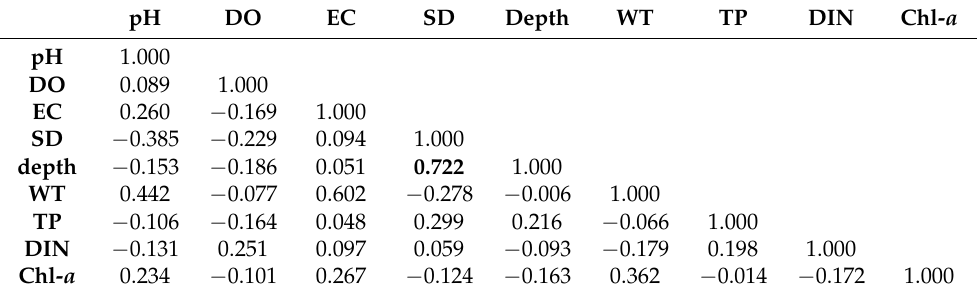
Table 1. Results of the Pearson correlation coefficient ( r ) for the monitored environmental